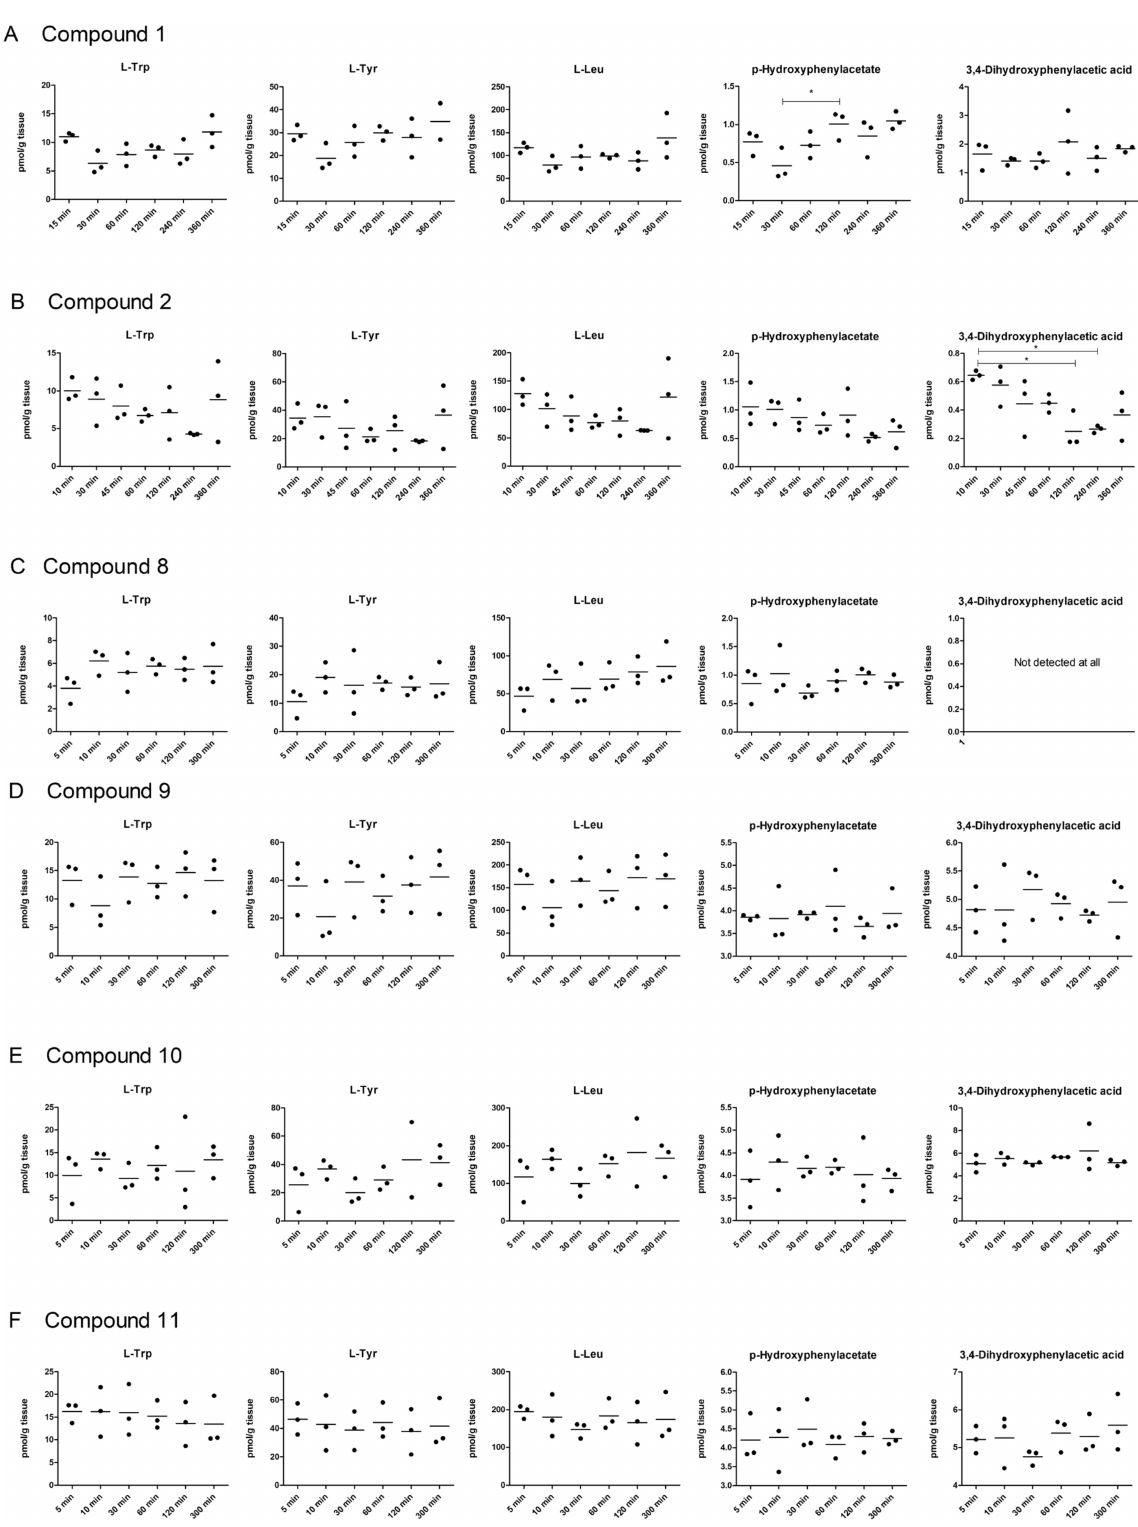
Figure 6. Brain amounts of amino acids L-Trp, L-Leu, L-Tyr and possible metabolites p - hydroxyphenylacetate and 3,4-dihydroxyphenylacetic acid of compounds 1 ( A ), 2 ( B ), 8 ( C ), 9 ( D ), 10 ( E ), and 11 ( F ) over 300–360 min period after a single dose of compound 1 (25 µ mol/kg, i.p.) to mice. The data are presented as mean of each time point ( n = 3) and an asterisk denotes a statisti- cally significant difference compared to the first time point (5–15 min) (* p < 0.05, one-way ANOVA followed by Dunnett’s